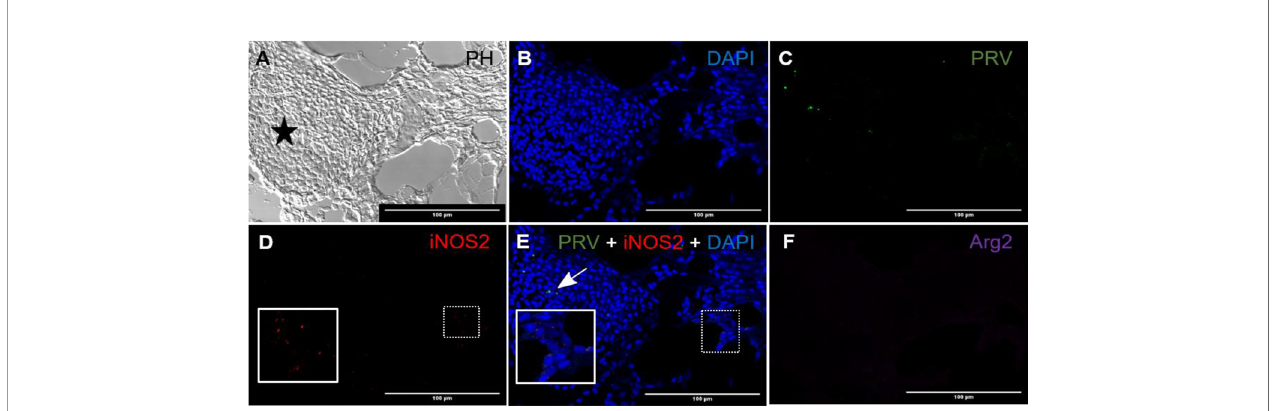
FIGURE 2 | Fluorescent in situ hybridization of PRV-1, iNOS2 and Arg2 in red focal changes (early phase) . (A) Phase contrast image showing a large hemorrhage (star). (B) DNA staining of the cells by DAPI (blue). (C) Presence of a few PRV-1 (green) positive cells in the hemorrhage. (D) iNOS2 (red) speci fi c transcripts detected in a limited number of cells surrounding a peripheral blood vessel. (E) Merged image showing presence of PRV-1 (arrow) but no co-localizing in the M1 macrophage (inset). (F) Arg2 (purple) speci fi c transcripts (M2 type macrophages) were undetected. Scale bar =